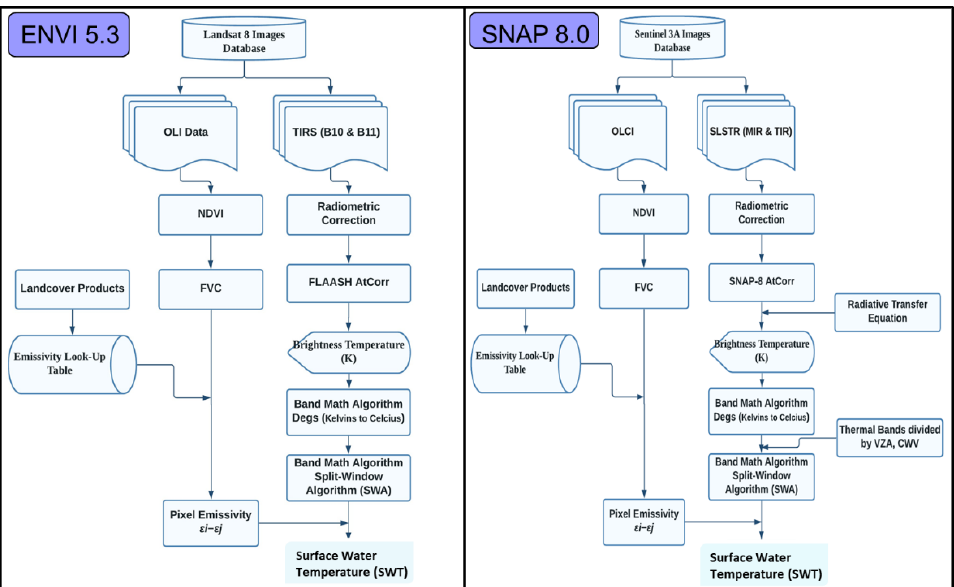
Figure 2. Workflow to show the process of retrieval of SWT from L8 and S3 images by ENVI 5.3 and SNAP 8.0 software respectively. SNAP 8.0 software